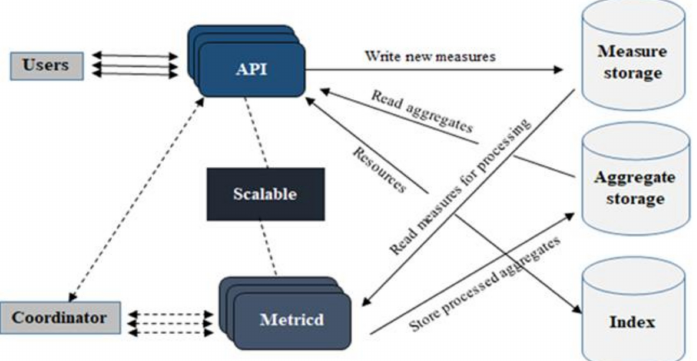
Figure 5. Gnocchi architecture.